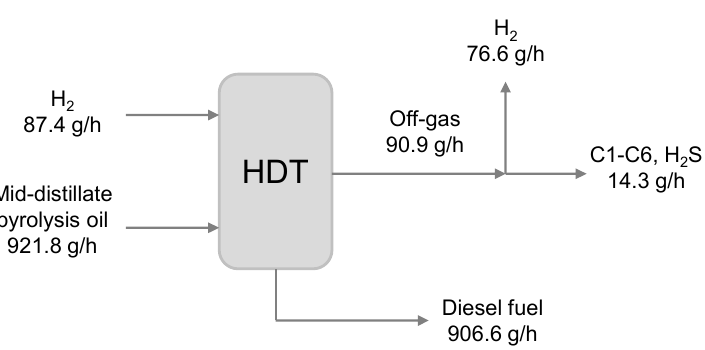
Figure 4. Mass balance of the catalytic hydrotreatment (HDT) of the mid-distillate pyrolysis oil fraction as estimated from the hydrotreating experiments at CERTH.